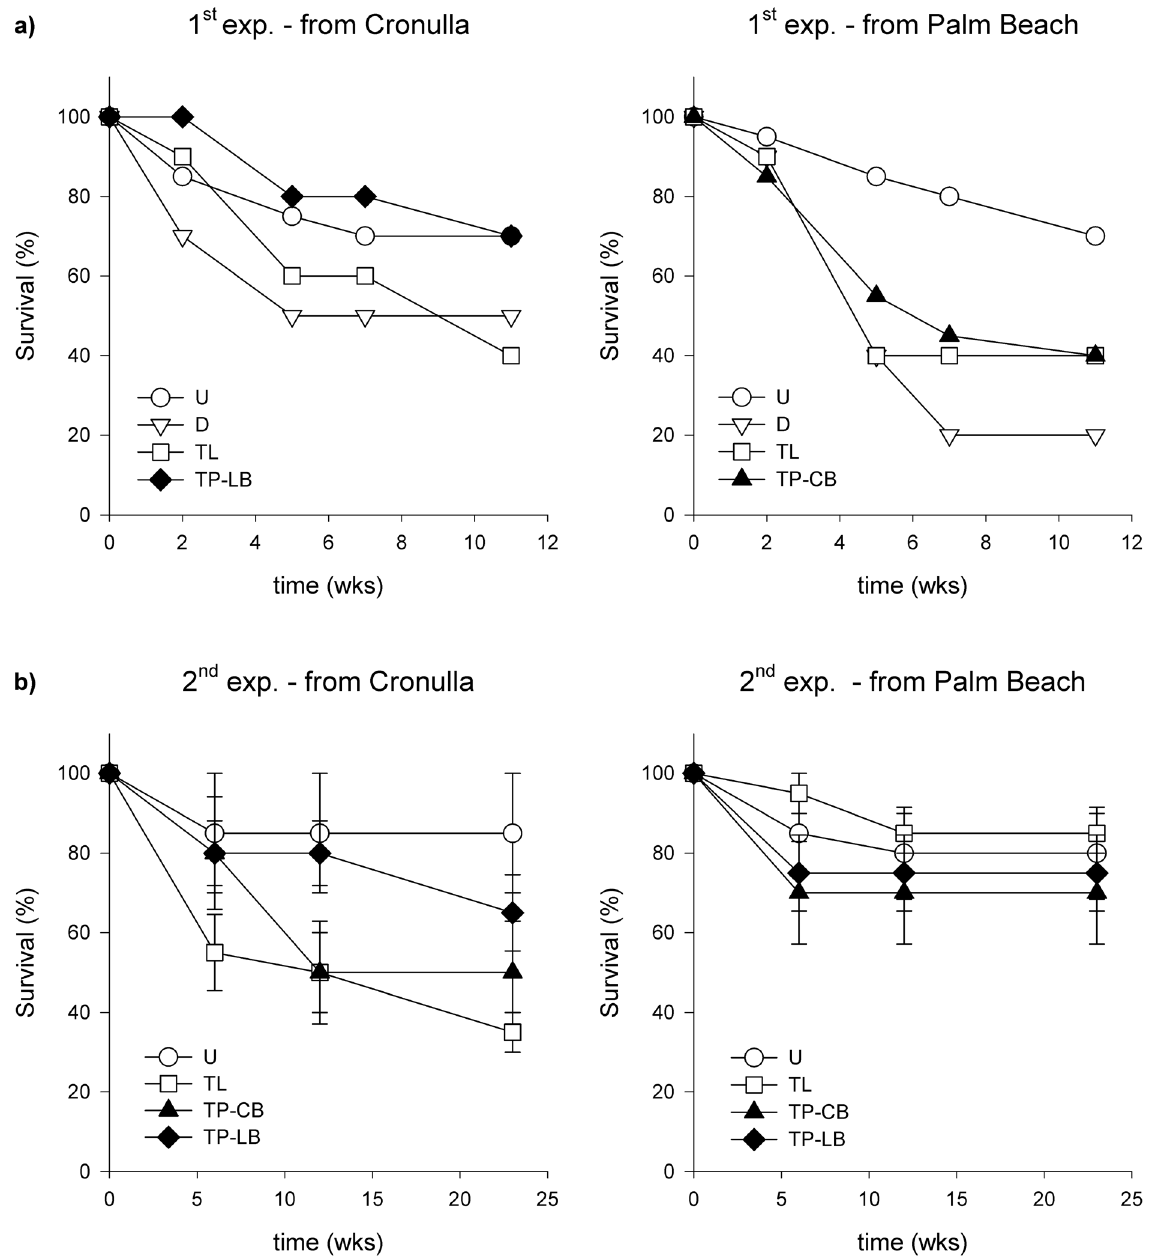
Figure 1. Survival (%) of Phyllospora in the (a) first (total for each site) and (b) second (mean ± S.E.; n =4) transplant experiments from Cronulla and Palm Beach to Long Bay and Cape Banks respectively. Treatments are Undisturbed (U; white circles), Disturbed (D; white triangles), Translocated (TL; white squares) and Transplanted to Long Bay (TP-LB; black diamonds) or Cape Banks (TP-CB; black triangles).